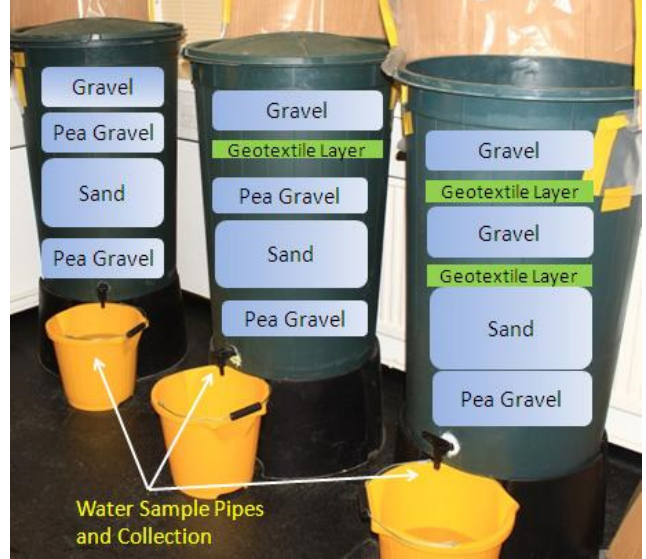
Figure 2. ( a ) Storage tank for stormwater undergoing aeration and prior to pumping to filters; ( b – d ) Granular Filter Rigs Nos. 1, 2 and 3 with varying layers of gravel, pea gravel, sand and geotextile membrane.